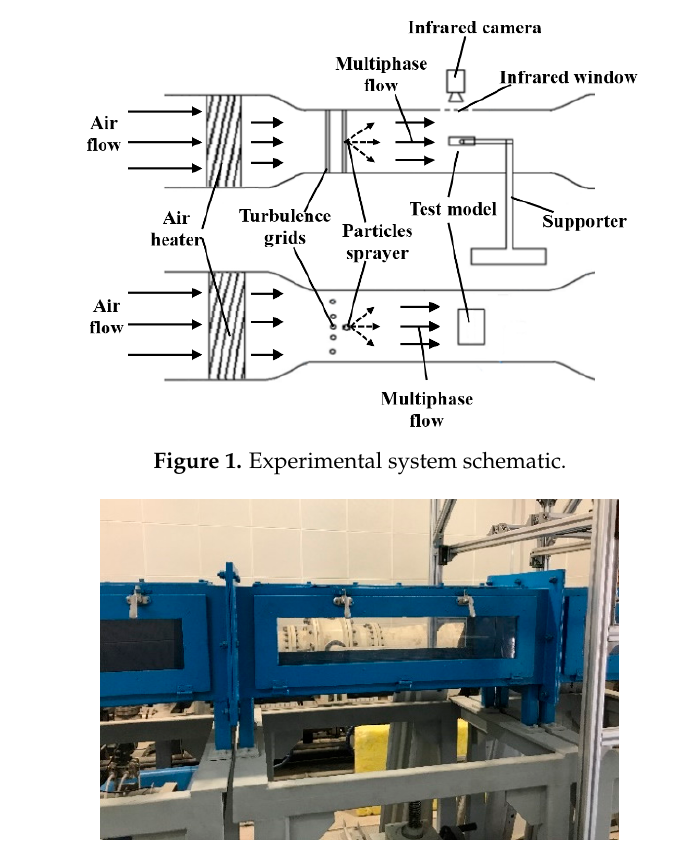
Figure 2. Photograph of the test section. Table 1. Operating parameter range and sensor accuracy.